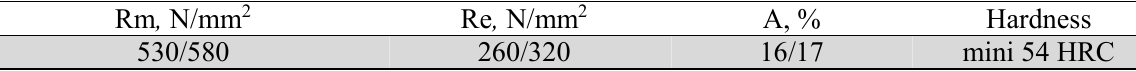
Mechanical characteristics of AISI 1040